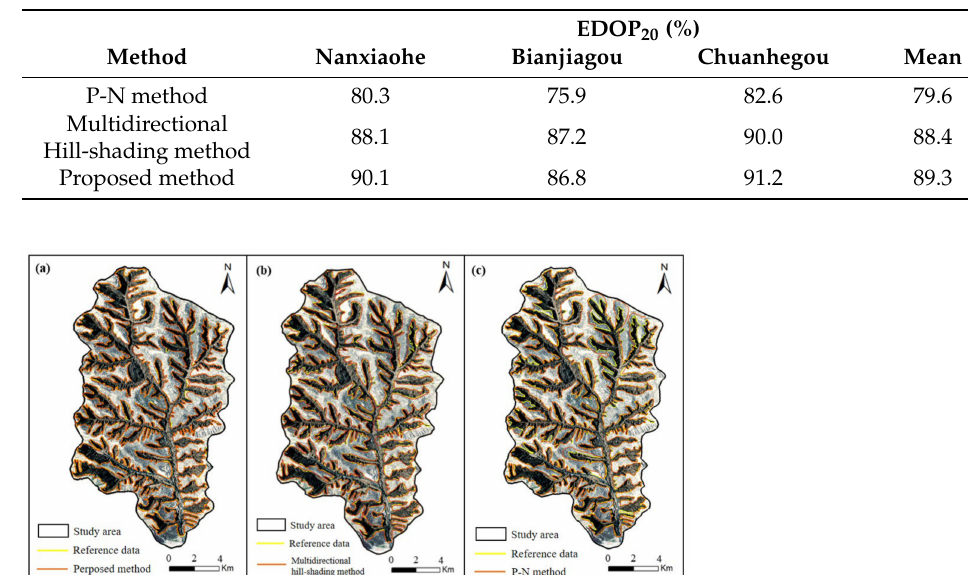
Table 4. Accuracy assessment of the three methods.